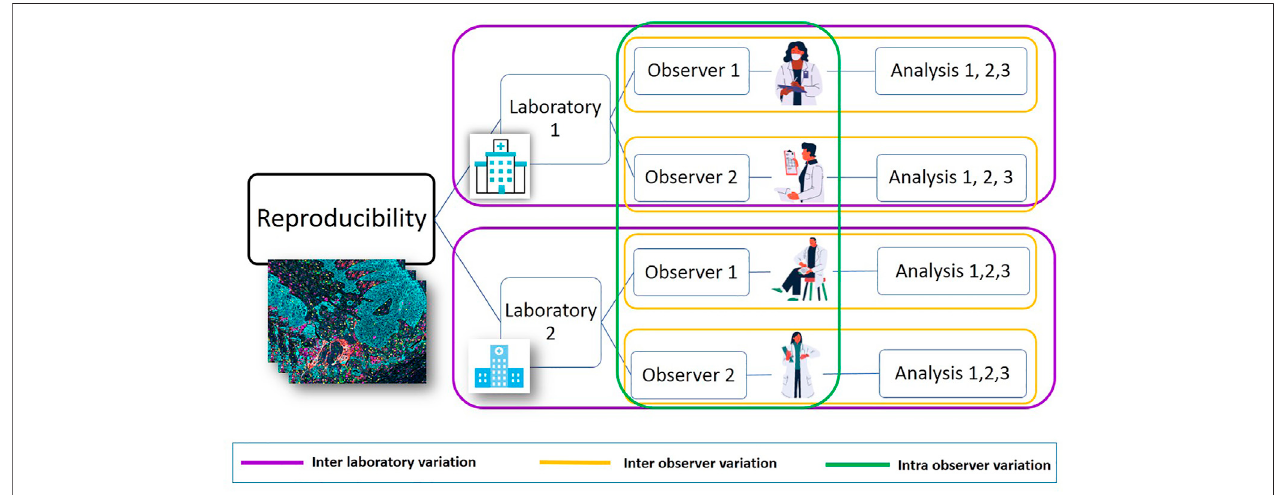
FIGURE4| Post-analytic reproducibility study. Itispossibletoaddressthe fl owofpost-analytic studies thatcompare results between twoormore sites. Each site canhavedifferentobservers,andeachcananalyzeslidesorprojectsmorethanonetimeusingimageanalysis.Thisalgorithmmakesitpossibleto fi ndvariabilitybetween laboratories. This work fl ow is useful for IHC/mIF and other techniques, improving the quality of the fi nal results. It is highly recommended to publish the results and fi